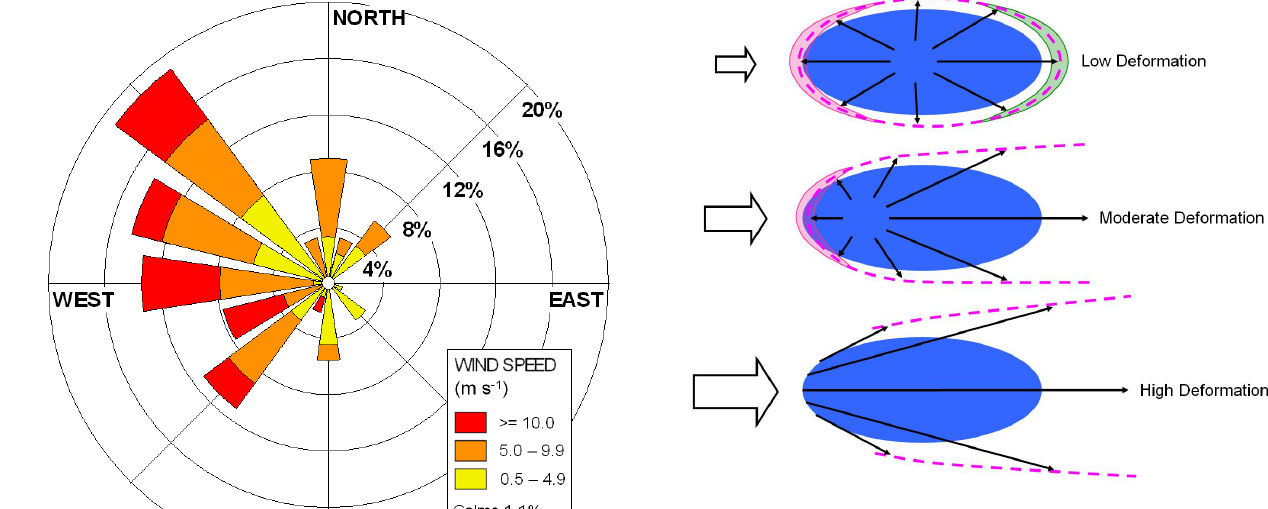
Fig. 6. Diagrams showing low-, moderate-, and high-deformation lake-breeze circulations in plan view. Black arrows are streamlines. Broken magenta lines are lake-breeze fronts. Large arrows at left represent the synoptic wind increasing from top to bottom. The synoptic wind results in a stronger front in magenta-shaded areas, and a weaker front in green-shaded